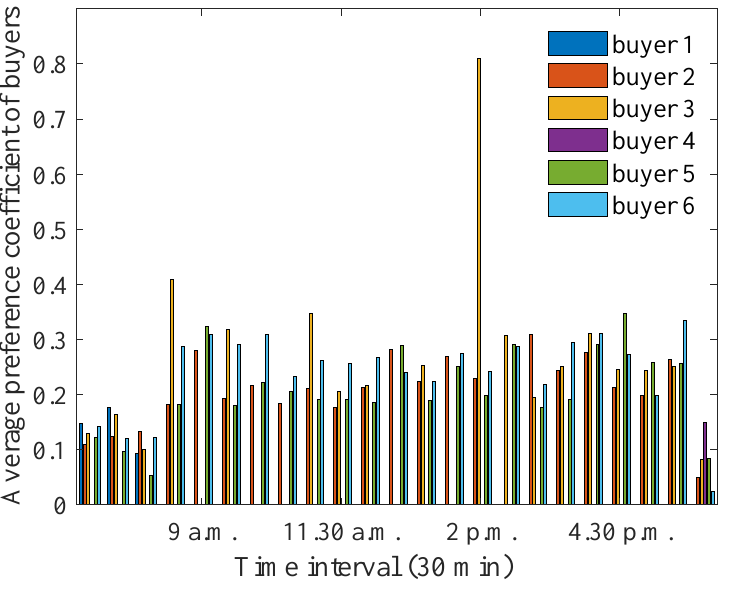
Figure 22. Optimum preference coefficients for buyers when distance between house 4 and the aggregator is